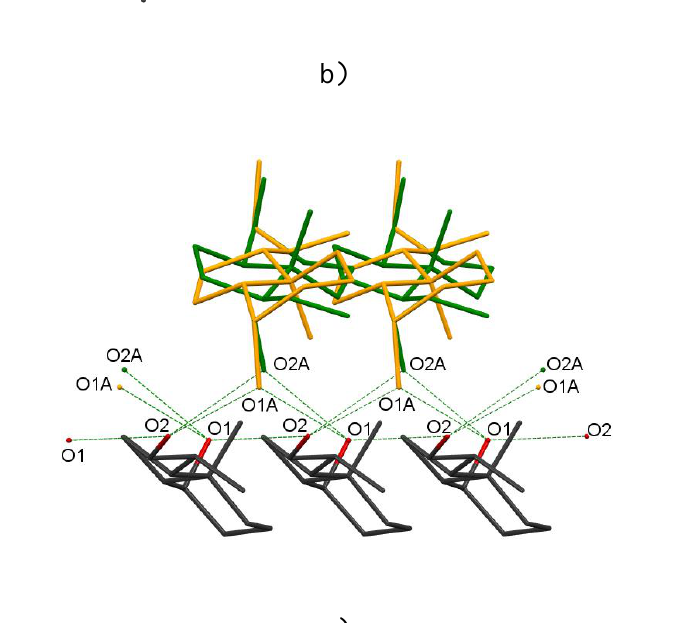
Figure 5. Energy frameworks for 1 , 2 , and vitamin D analogues. Results for all frameworks were presented for the total energy, using the scale factor equal to 50, and the value of energy threshold was equal to 5 kJ/mol.